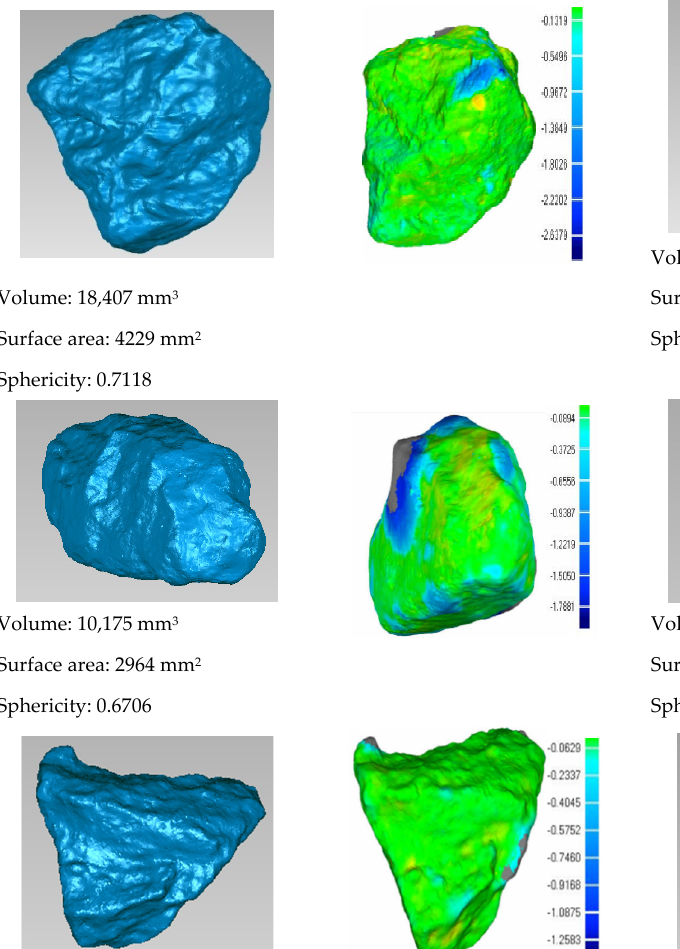
Figure 20. Illustration of abrasion depth calculation.